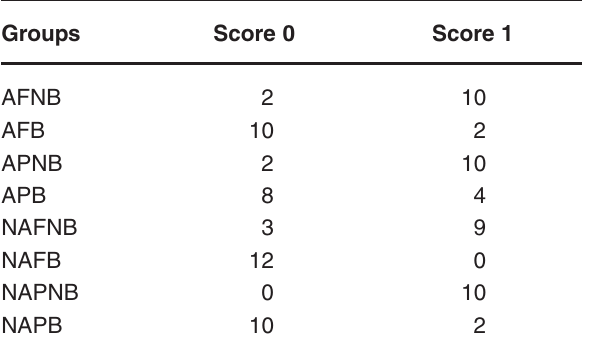
TABLE 2- Scores of caries formation around composite restorations for each group in the different conditions evaluated